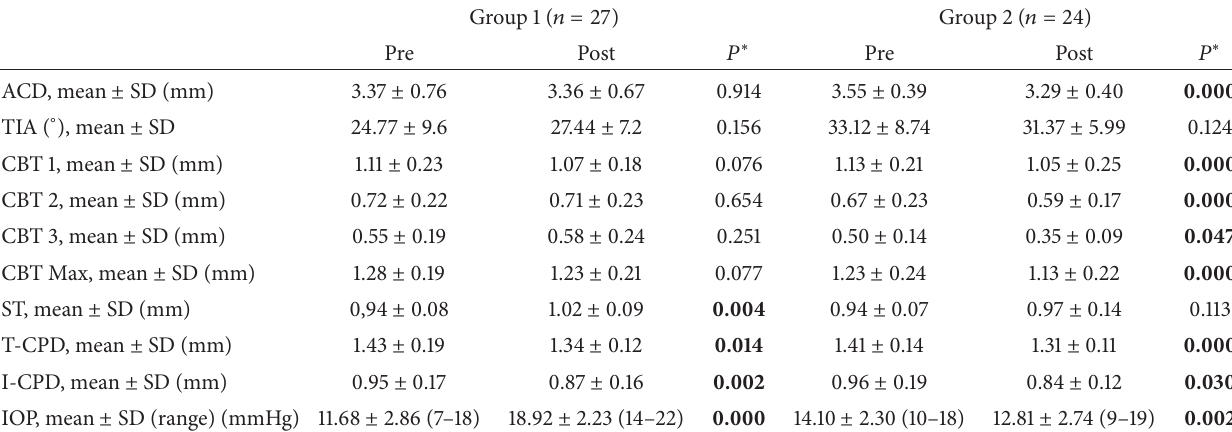
ACD: anterior chamber depth; LT: lens thickness; TIA: trabecular meshwork-iris angle; CBT 1, 2, and 3: ciliary body thicknesses 1, 2, and 3mm, CBT Max: maximum ciliary body thickness; ST: sclera thickness; T-CPD: trabecular meshwork-ciliary process distance; I-CPD: iris-ciliary process distance; SD: standard deviation; ∗ paired 𝑡 -test.